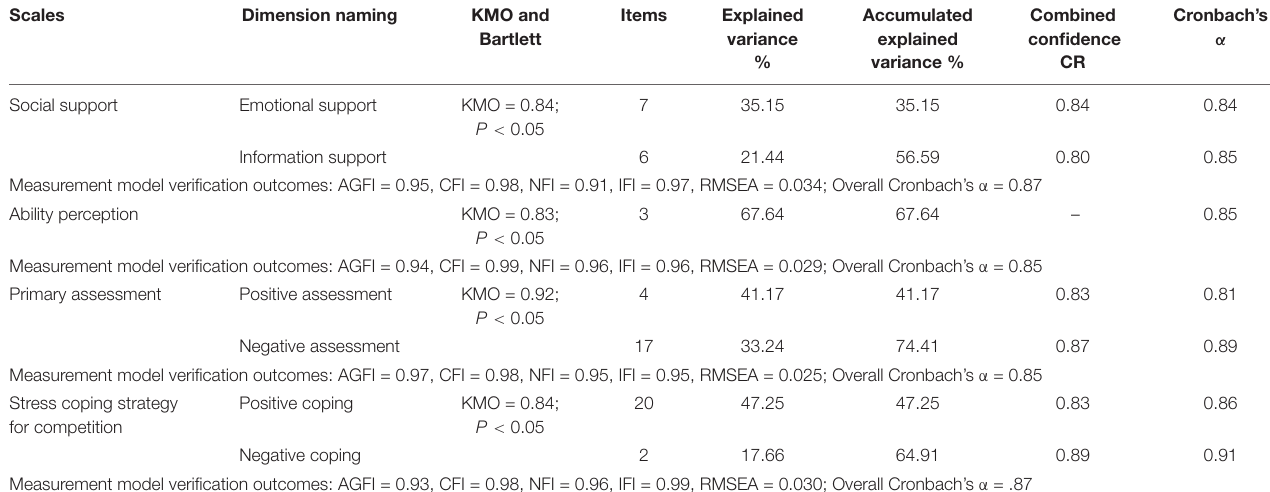
TABLE 1 | Quality analysis of four measurement scales. Scales Dimension naming KMO and Social support Emotional support KMO = 0.84;